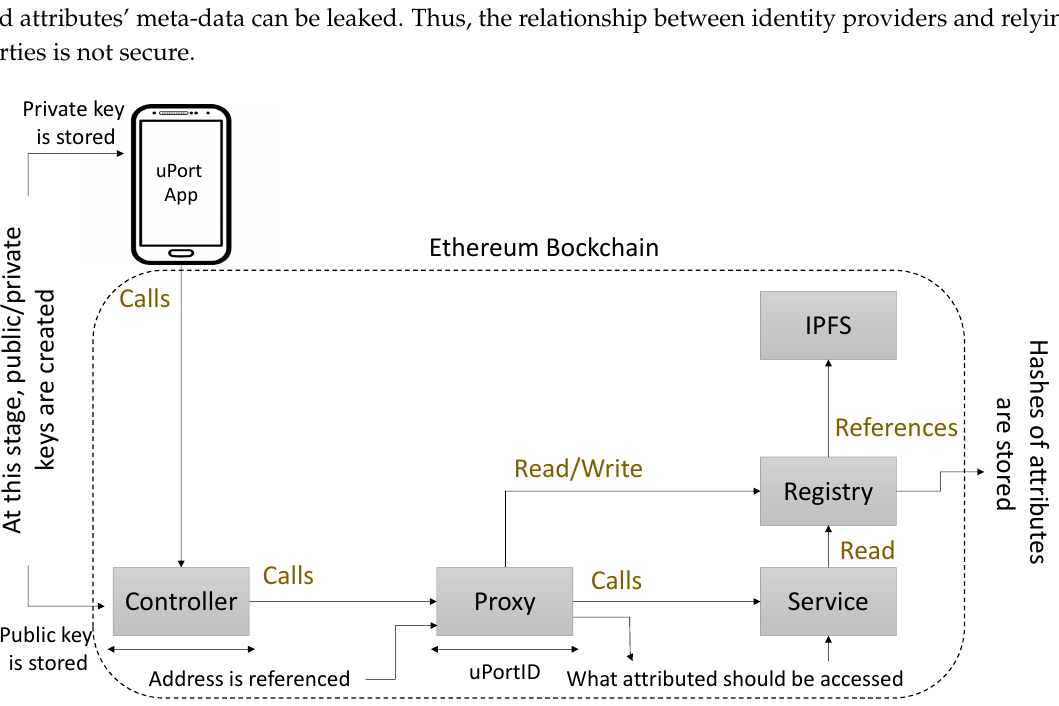
Figure 2. The general architecture of uPort. IPFS, InterPlanetary File